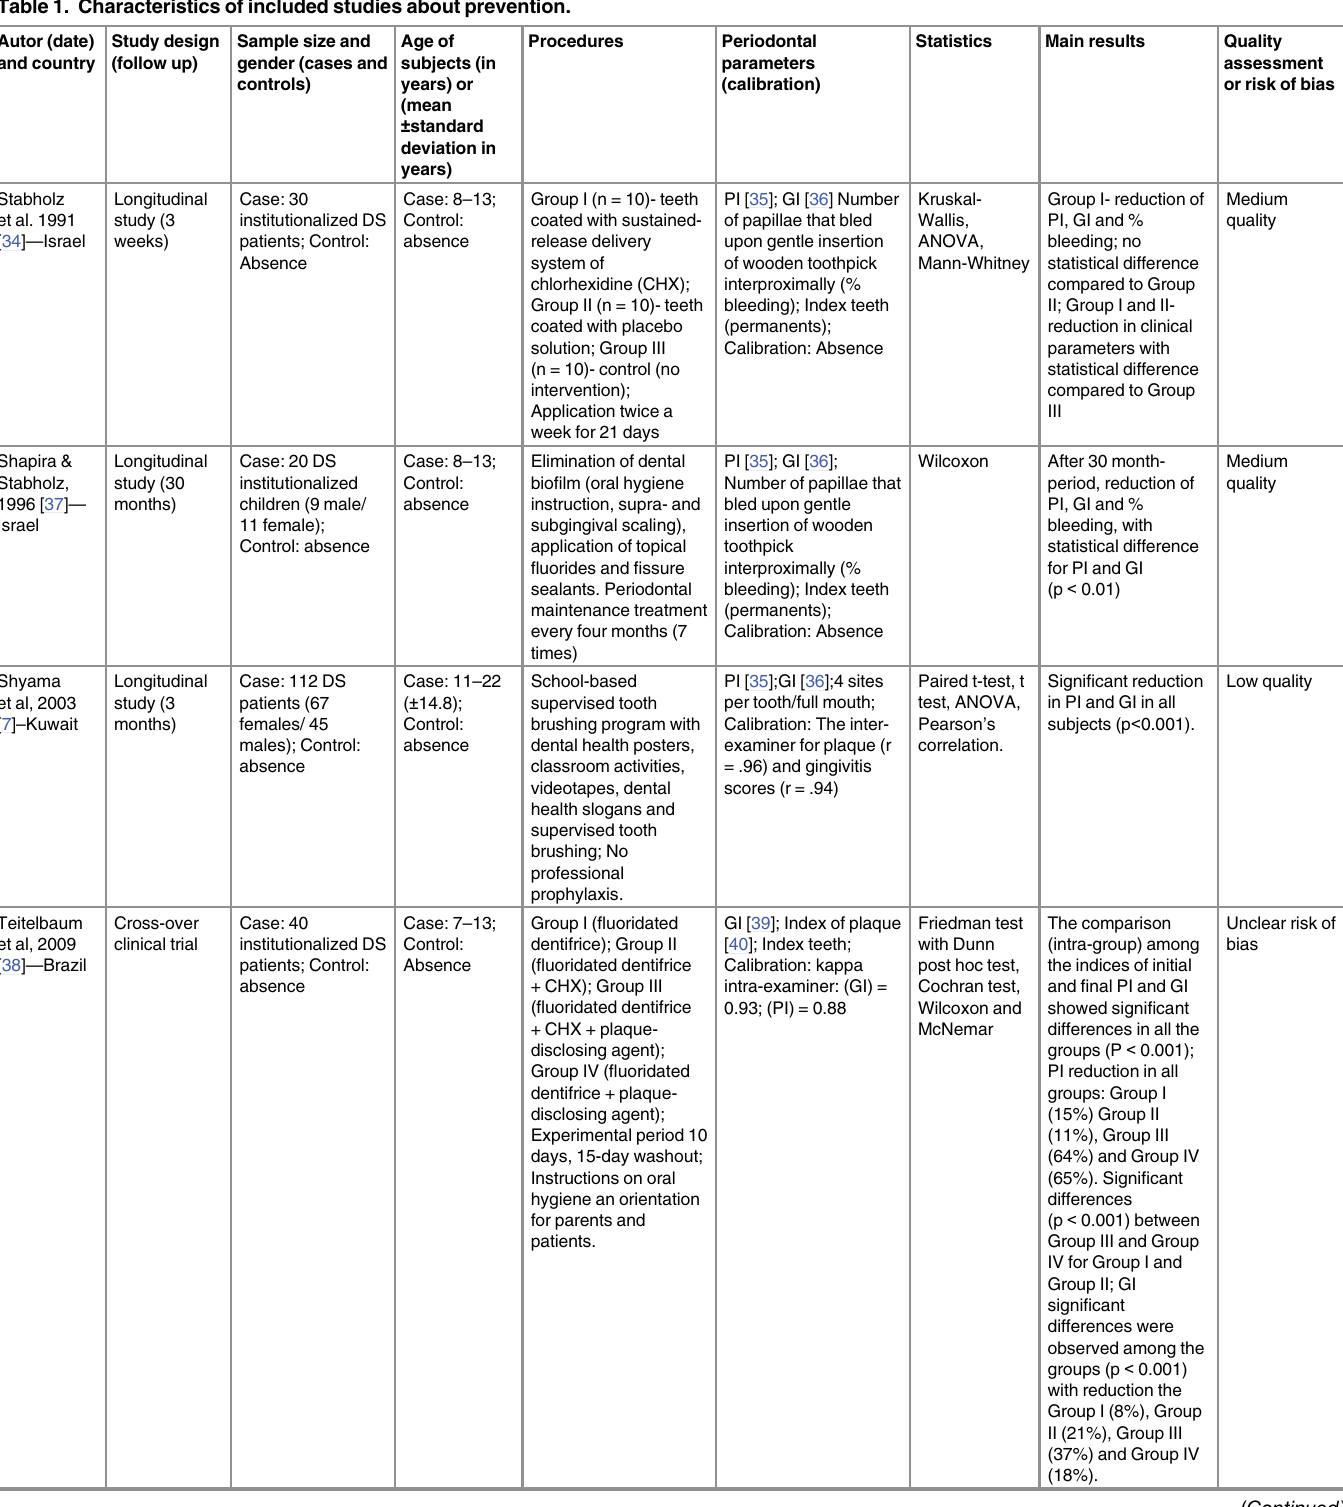
Table 1. Characteristics of included studies about prevention. Autor (date) Study design and country (follow